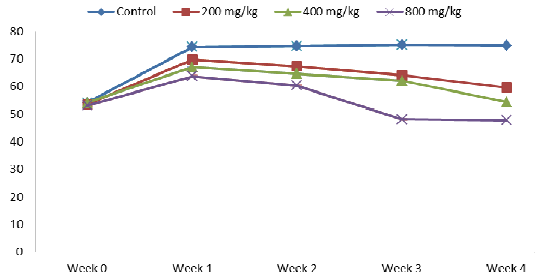
Fig. 1. Effect of Lipton tea aqueous extract on body weight gain of normal albino rat